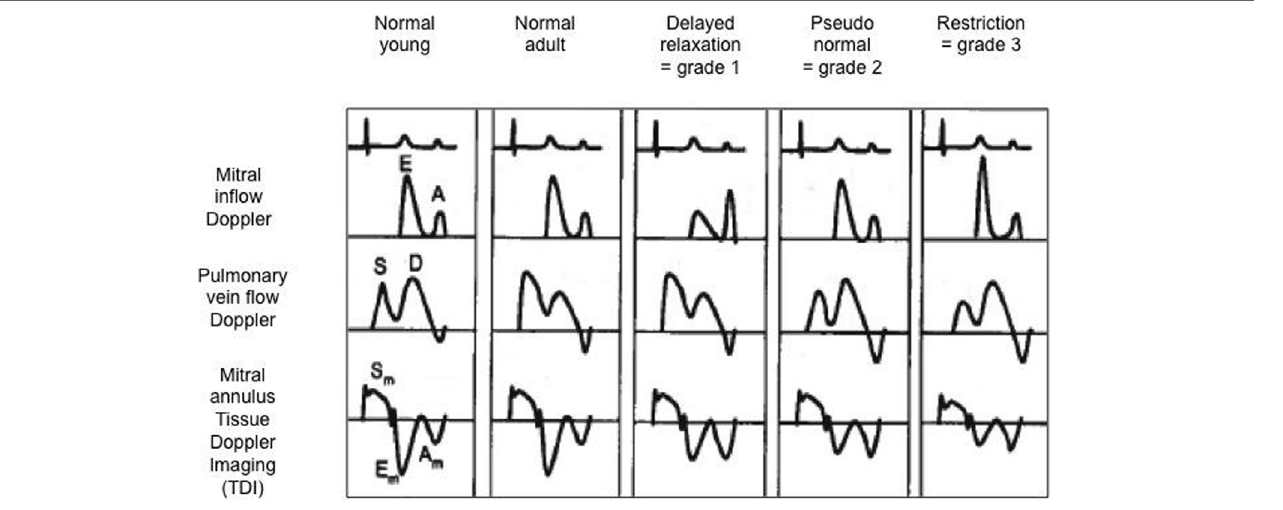
TAbLe 1 | Evaluation of diastolic function using mitral inflow Doppler, pulmonary venous Doppler and mitral annulus tissue Doppler pattern with classification into normal, delayed relaxation ( = grade 1 or mild diastolic dysfunction), pseudo-normal ( = grade 2 or moderate diastolic dysfunction), and restriction ( = grade 3 or severe diastolic